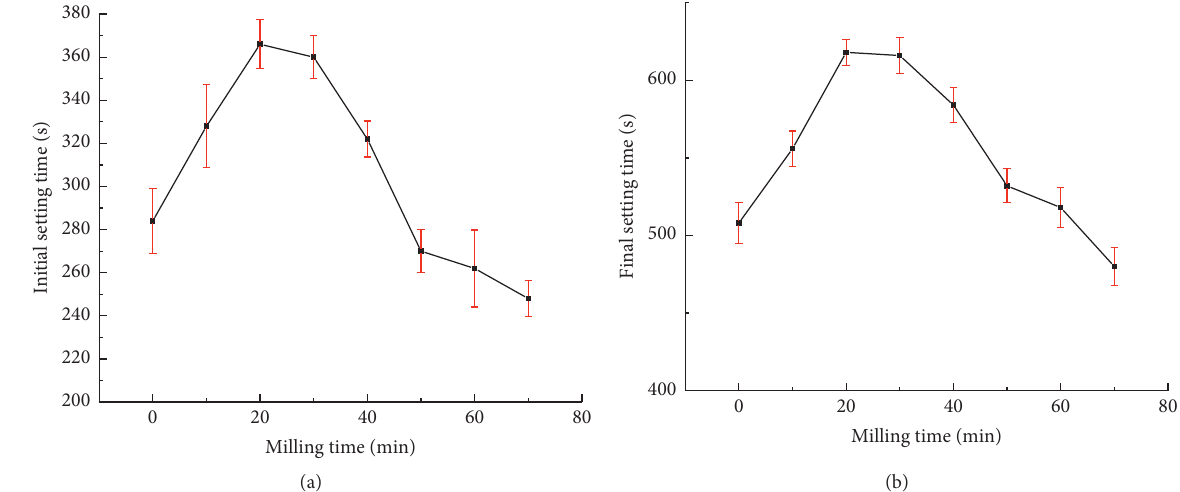
Figure 6: Variation of the setting time of PBG with ball milling time. (a) Initial setting time. (b) Final setting